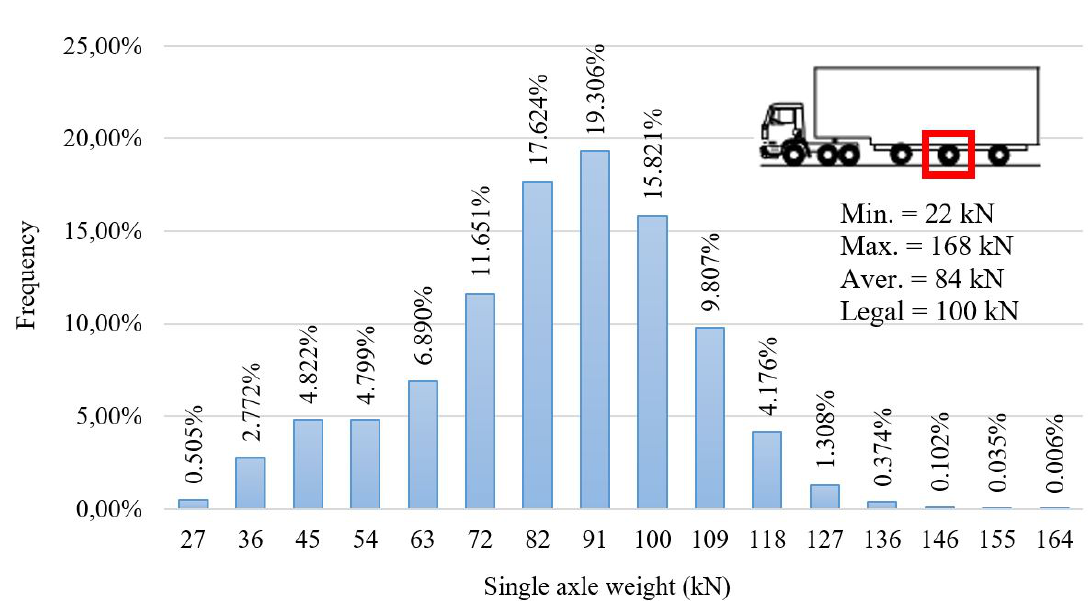
Figure 8. Histogram for weight for single axle for class 3I3, which the horizontal axis shows the average values for each interval (the histogram for single axles for 3I3 are similar).